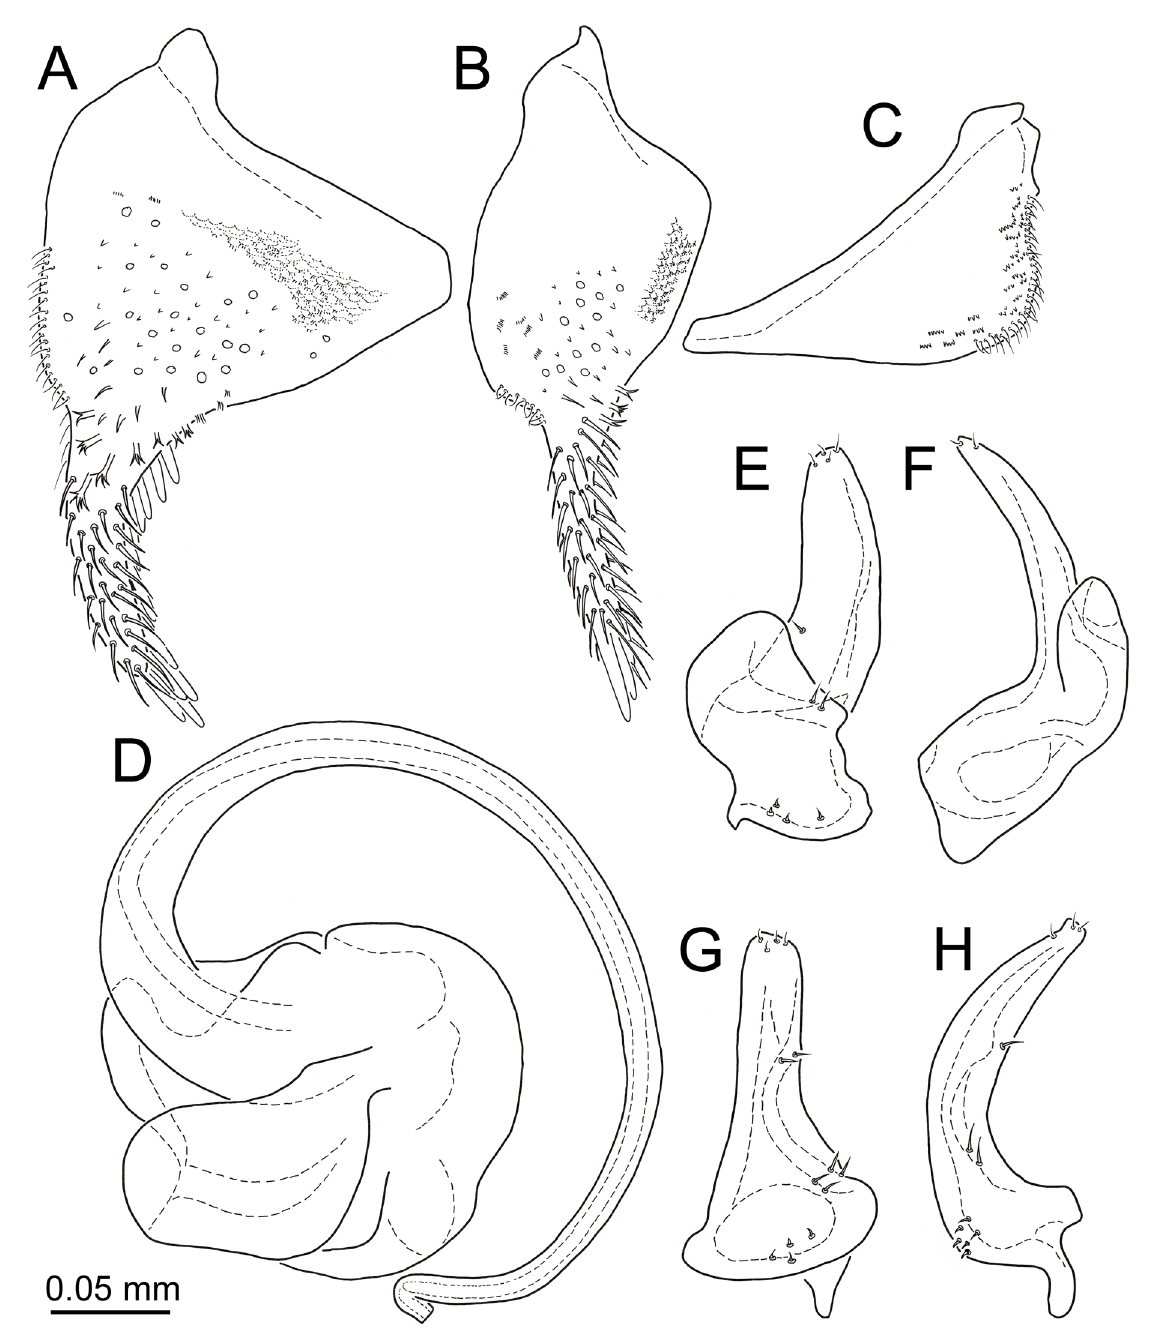
Fig. 6. Kokeshia bui sp. nov., segment VIII and genitalia, paratype, ♂ (SYSBM). A‒B . Left hemitergite VIII. A . Dorsal view. B . Left lateral view. C . Right hemitergite VIII, dorsal view. D . Phallus. E‒F . Left paramere, two different aspects. G‒H . Right paramere, two different